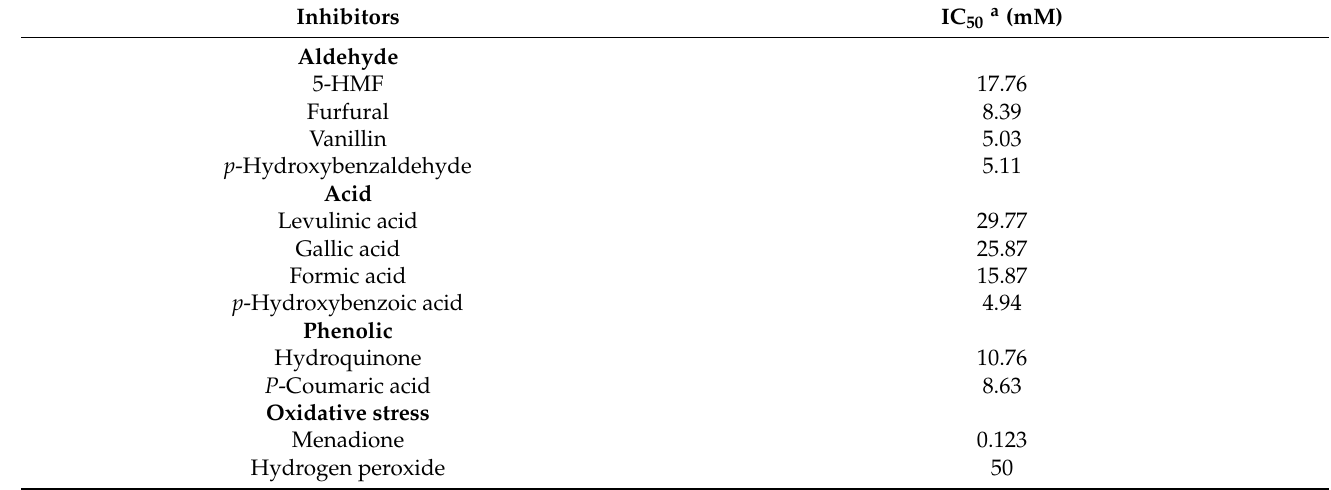
Figure 3. Tolerance of Colletotrichum sp. OH to lignocellulosic-derived inhibitors. ( A ) The mycelial growth in the presence of three groups of inhibitors; aldehydes, acids, and phenolics (HMF, FU, furfural; VA, vanillin; PHB, p -hydroxybenzaldehyde; LA, levulinic acid; FA, formic acid; GA, gallic acid; POH, p -hydroxybenzoic acid; HQ, hydroquinone; PCA, p -cumaric acid). ( B – G ) ( B , D , F ) is the relative mycelial growth (%) in plates and ( C , E , G ) dry weight biomass (g/L) of OH on the seventh day when supplemented with and without inhibitors. The control (no inhibitors) plate showed 9 cm mycelial growth on the 7th day of incubation. Experiments were performed in triplicate, and the heights of the bars and the error bars show the means ± standard error mean (SEM). Table 2. The concentration of inhibitors required to inhibit the growth of OH to